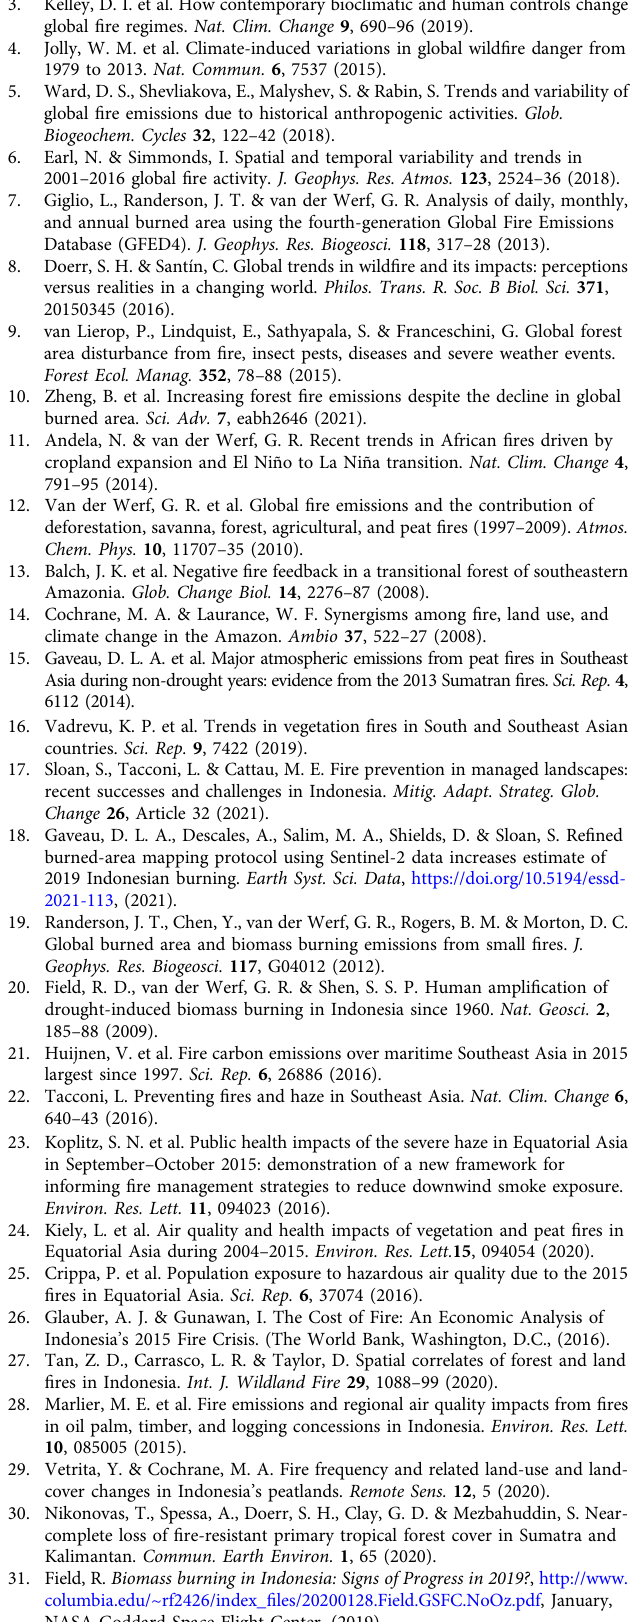
(Table 2). Regressions were fi tted for four sets of fi re activity: (a) AFDs of severe fi re events, (b) ignition AFDs of severe fi re events, (c) AFDs of all fi re events, and (d) ignition AFDs of all fi re events, as per Table 2 panels a – d. Signi fi cant negative/ positive trends indicate a decreasing/increasing prevalence of a land use/cover amongst the fi re events or ignitions of a given set. We determined the land uses/covers of AFDs annually over 2002 – 2019 based on AFDs ’ spatial overlap with the annual 300-m Copernicus Climate Change Initiative Land-Cover Product 100,101 (Table 1, Fig. 4). These Copernicus data provide relatively stable, accurate, annual land-use/cover classi fi cations 102 and, crucially, greater differentiation between and amongst land uses and degraded land covers (Supplementary Table 6) compared to other land-cover data used to explore Equatorial Asian burning 27,36,69,103 . In particular, our data observe three agricultural classes along a spectrum of management intensity (Table 1). Veri fi cation of these classes against land use visually interpreted using high- resolution imagery across 8 Mha of the fi re-affected regions af fi rm the classes ’ nominal management intensities (Supplementary Note 3). Annual land-use/cover observations account for all land-use/cover transitions over 2002 – 2019. We do not however focus on the particular role of transitions in shifting severe fi re activity, nor on the degree to which a shift in land-use/cover class prevalence amongst fi re events or ignitions re fl ects class expansion or contraction. The in fl uence of transitions and class expansion/contraction is considered secondary to negligible over our observation period, relative to the in fl uence of generalised trends in the use and management of a land use/cover class overall, considering the conservative change-detection algorithm of the Copernicus data and the relatively very small area of expansion/contraction relative to total class extent. For Indonesia and each of its regions, severe fi re events for fi re-activity sets (a) and (b) in Table 2 were de fi ned respectively as the top 25% of AFDs and ignition AFDs with respect to the severity scores of corresponding fi re events of 2002 – 2019